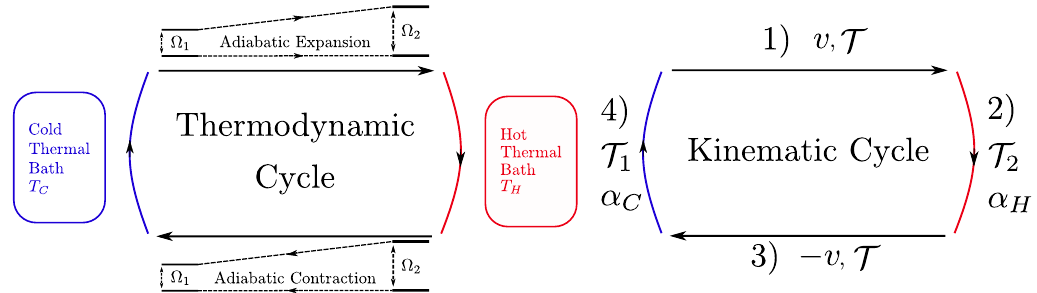
Figure 1. The kinematic and thermodynamic cycles of the Unruh quantum Otto engine adapted from ref. [19]. Acceleration plays the role of temperature and contact with the quantum vacuum is analogous to a thermal